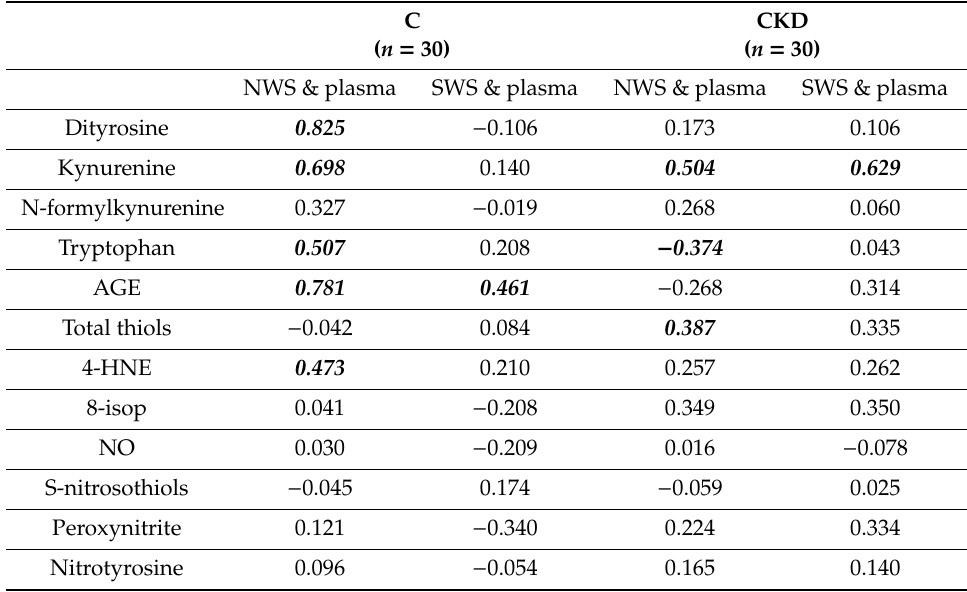
Table 5. Correlations between salivary and plasma redox biomarkers in children with chronic kidney disease (CKD) and healthy